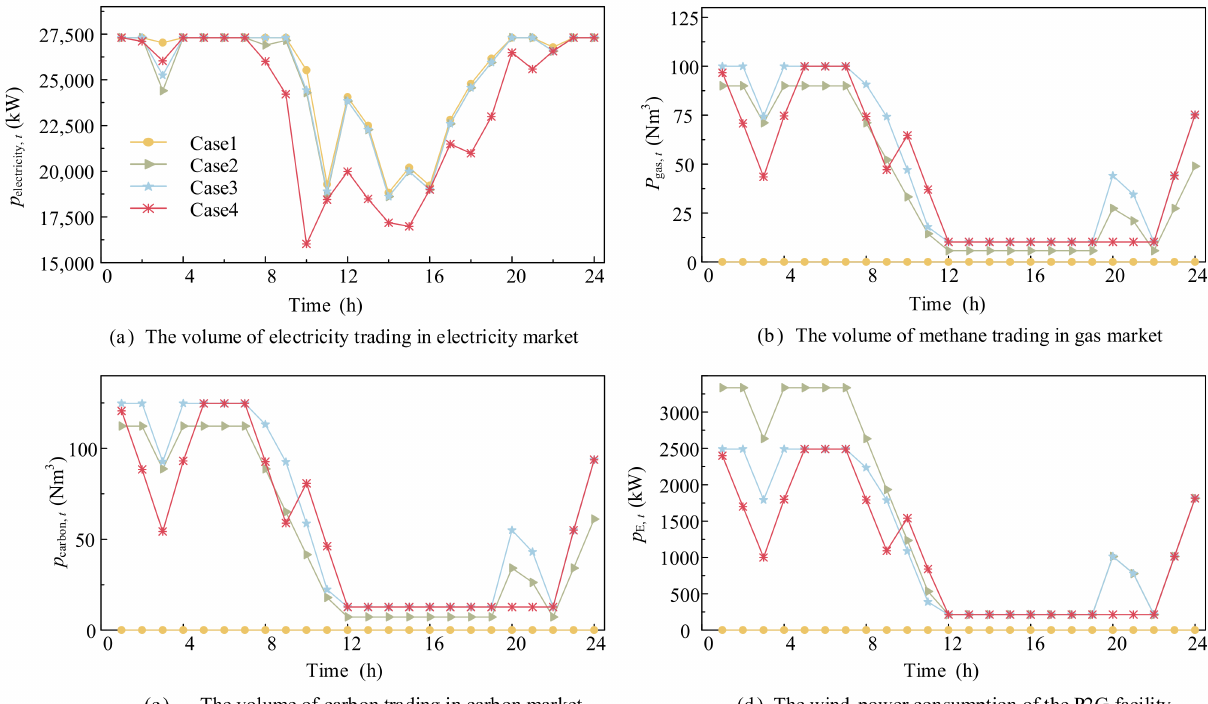
Figure 4. Day-ahead optimal scheduling results of P2G in remote wind farms considering multiple energy